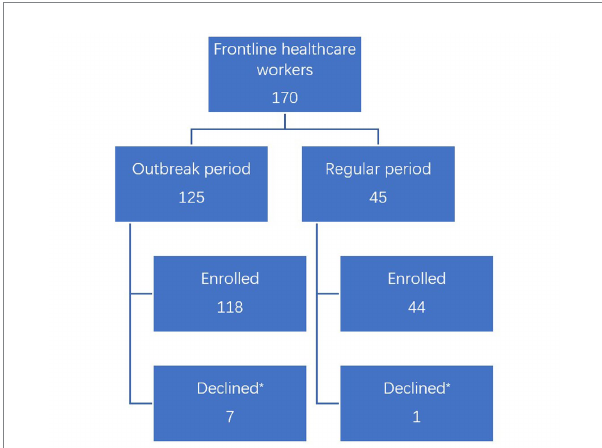
FIGURE 1 Flowchart of study